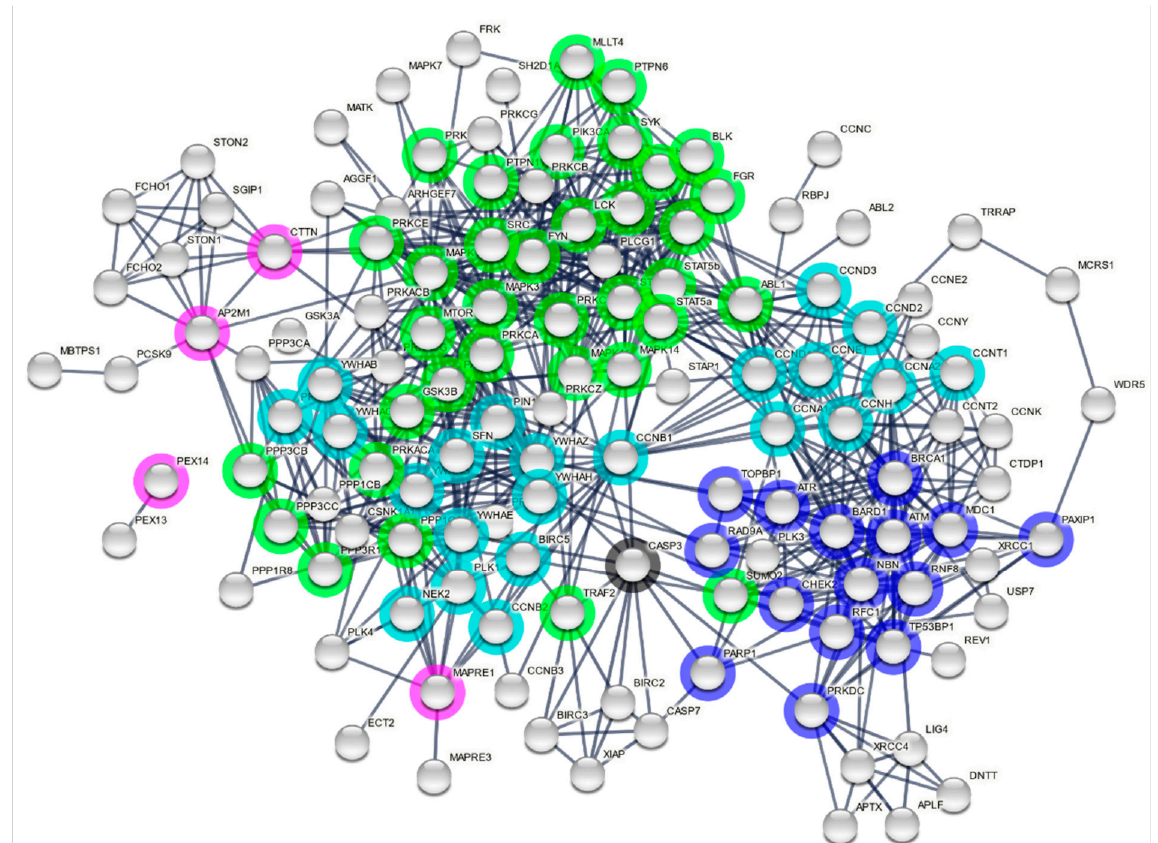
Figure 3. Predicted ERVK integrase interactome. Cellular proteins containing complementary interaction motifs for ELMs identified in Endogenous retrovirus-K (ERVK) integrase were listed as query proteins for STRING network analysis. Only query proteins with a minimum interaction score of 0.9 based on experiments and databases as interaction sources are indicated. Edges indicate both functional and physical protein associations. A payload list was generated to color nodes and hubs related to dominant pathways: DNA damage response (dark blue), cell cycle (cyan), apoptosis (black), cell signaling (green), and cell transport